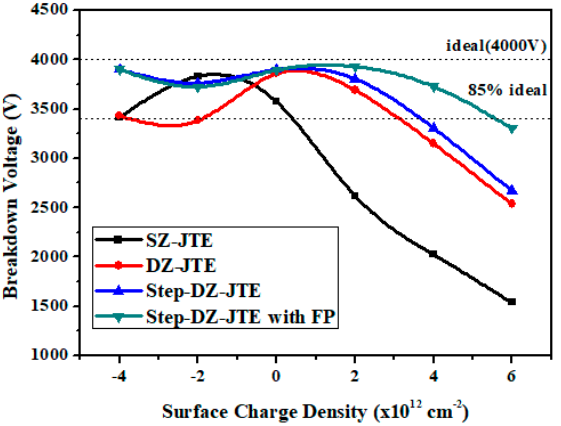
Figure 9. Simulated BV versus surface charges for SZ-JTE, DZ-JTE, Step-DZ-JTE without FP, and Step-DZ-JTE with FP. Table 2. Basic properties of different JTEs.